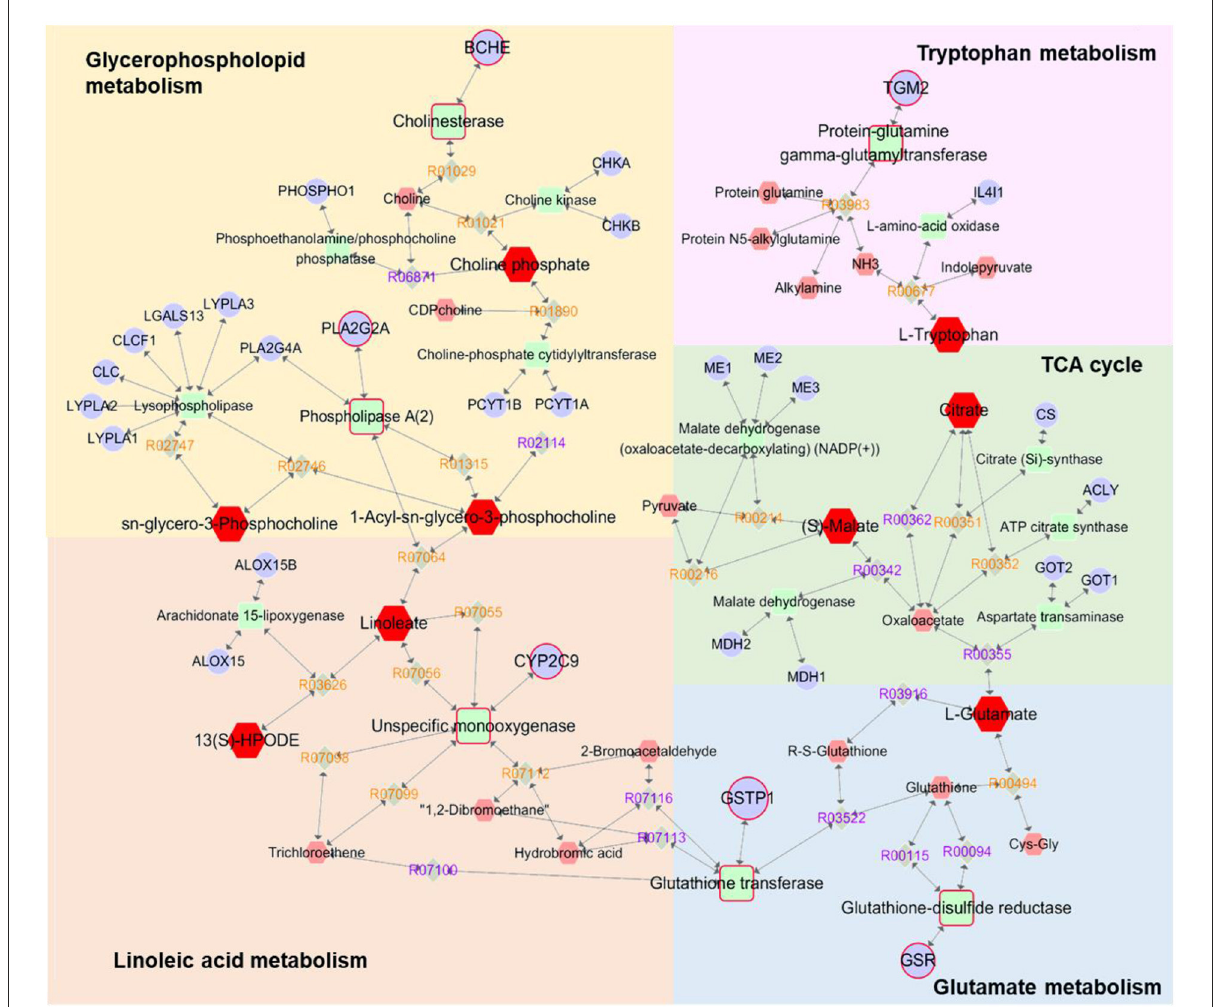
FIGURE4 Compound-reaction-enzyme-gene networks of the key metabolites and targets. The red hexagons are differential metabolites, gray diamonds are reactions, green round rectangles are proteins and purple circles are genes. The key metabolites, proteins and genes were magnified.